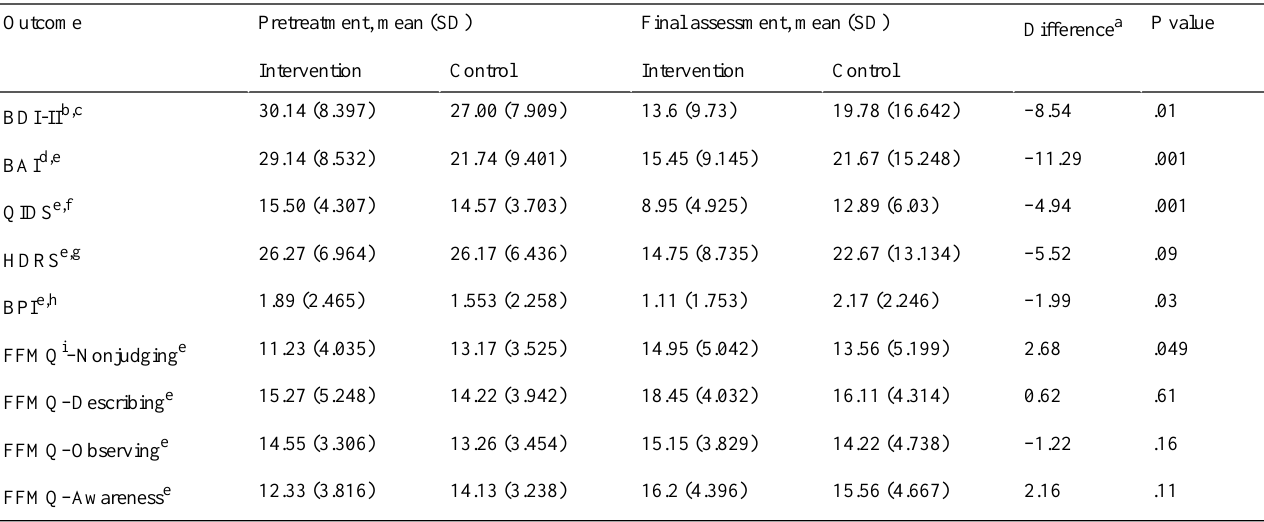
Table 2. Between-group differences based on intention-to-treat analysis (N=45).